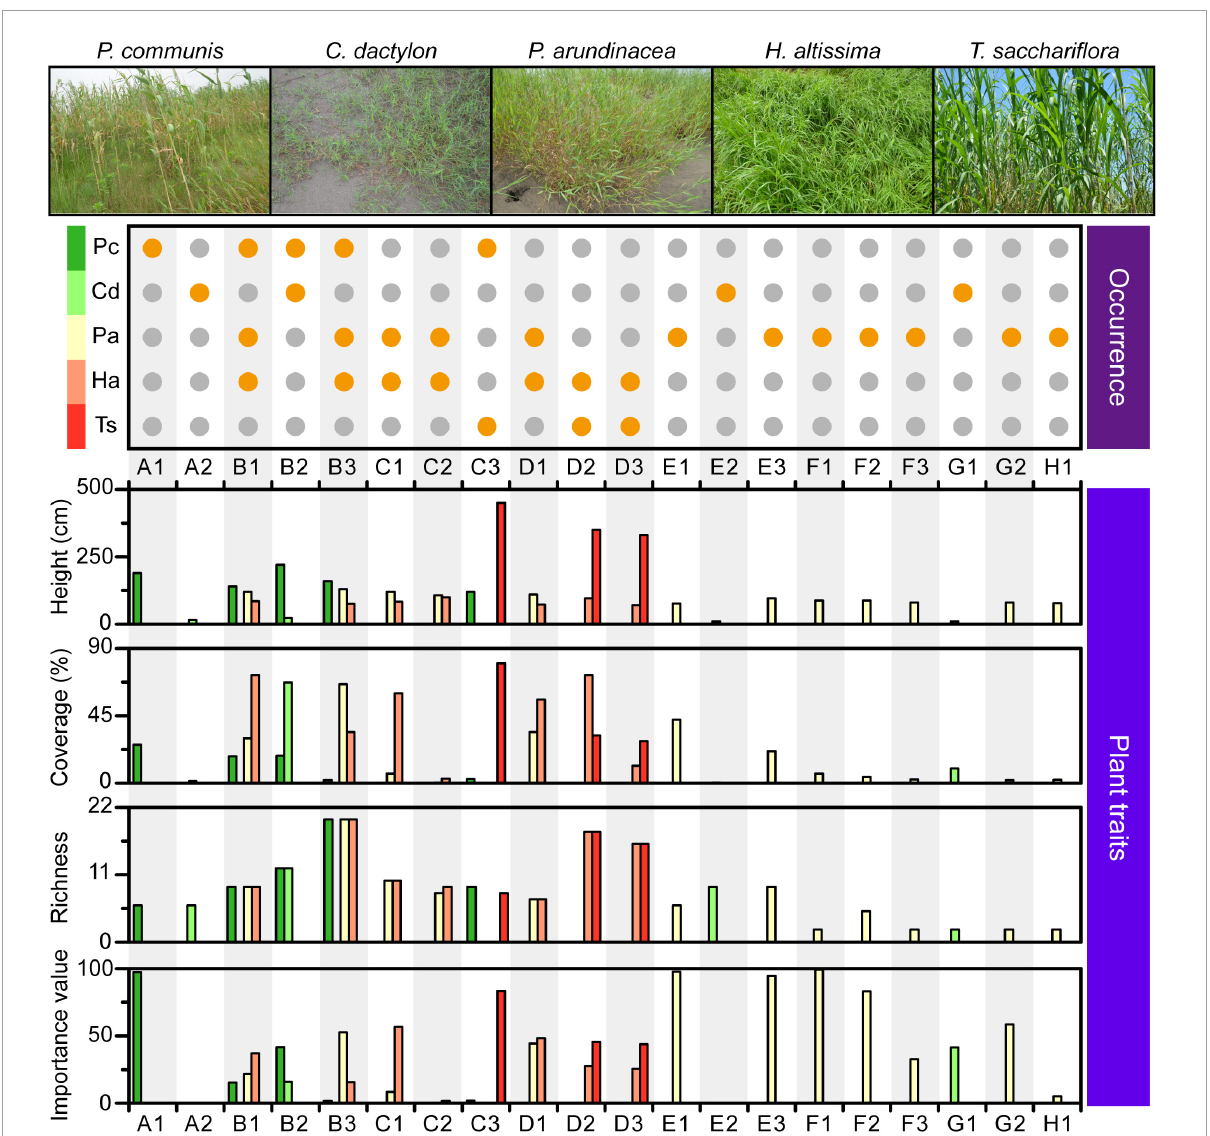
FIGURE3 Characteristics of the plant community found within each quadrat. Orange dot in the top plot: occurrence of each plant species, denoted on the left, in the corresponding quadrat. Combination of capital letter and number: quadrat identity; capital letters and numbers: longitudinal position and transect order of quadrats, respectively. Pc, P. communis ; Cd, C. dactylon ; Pa, P. arundinacea ; Ha, H. altissima ; Ts, T. sacchariflora